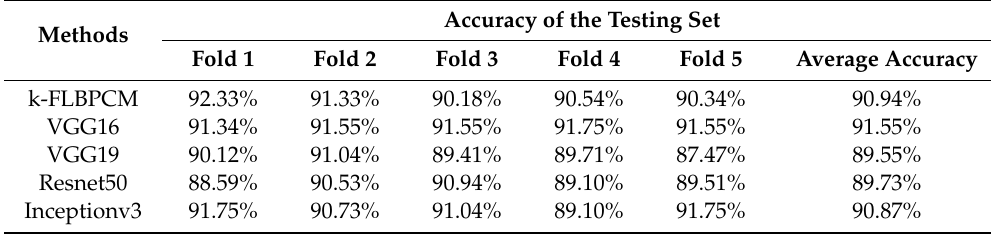
Table 8. Classification accuracies of the test set, in the “fieldtrip_can_weeds” dataset, for di ff erent methods, for a batch size of 32 and dropout 0.5.